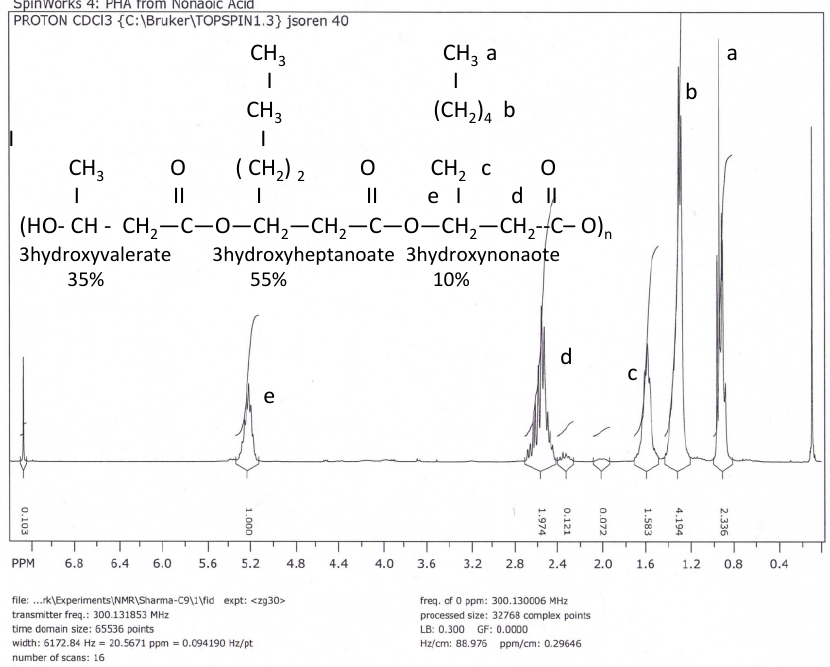
Figure 2. 1 H ‐ NMR spectrum of PHA isolated from P. putida LS46123 grown in RMM medium with Figure 2. 1 H-NMR spectrum of PHA isolated from P. putida LS46123 grown in RMM medium with nonanoic acid. nonanoic